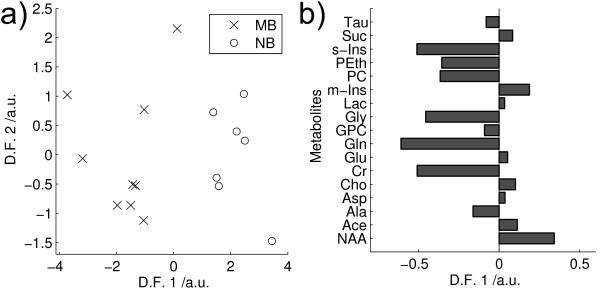
LDA MB vs NB. Linear discriminant analysis of Medulloblastoma vs Neuroblastoma performed on the first 5 principal components of the fitted metabolite quantities, showing a) Discriminant function (DF) scores and b) DF 1 metabolite coefficients. Tau – Taurine, Suc – Succinate, s-Ins – scyllo inositol, PEth – phosphorylethanolamine, PC – phosphorylcholine, m-Ins – myo-inositol, Lac – lactate, Gly – glycine, GPC – glycerophosphorylcholine, Gln – glutamine, Glu – glutamate, Cr – creatine, Cho – choline, Asp – aspartate, Ala – alanine, Ace – aspartate, NAA – N-acetylaspartate. (classifier accuracy: 94%).